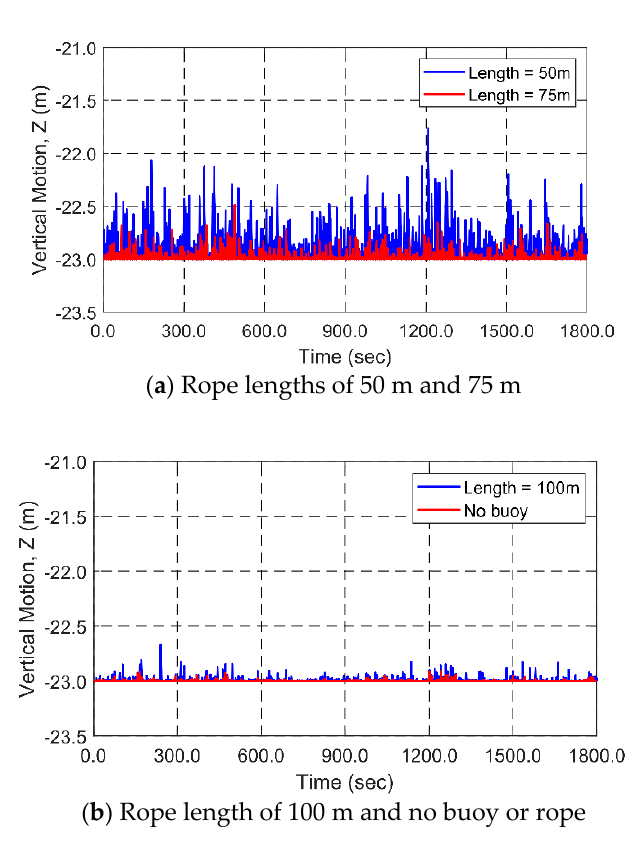
Figure 11. Time histories of the dry length of the location buoy in the middle location for H s = 2.0 m, T p = 7.0 s, and current velocity = 0.6 m/s (the pink line is a reference level which the dry length should be higher than to prevent the buoy from being fully submerged).